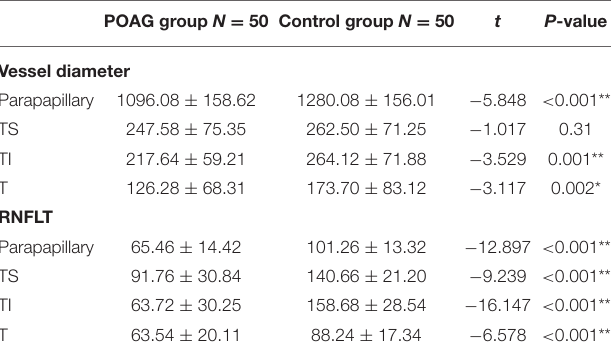
TABLE 2 | Comparisons of RVs and RNFLT between the POAG and control groups.